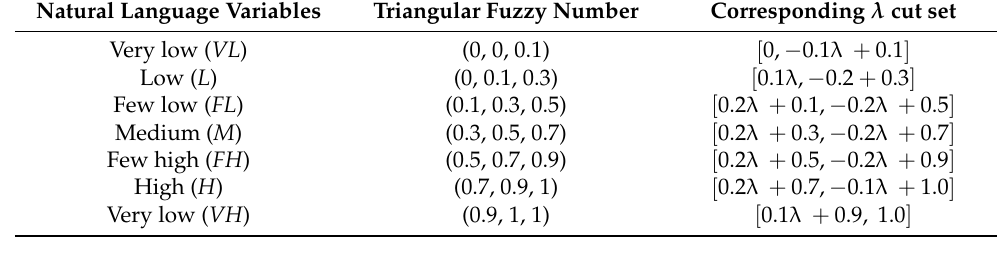
Table 4. The corresponding relationship between natural language variables of grade 7 and triangular fuzzy numbers.